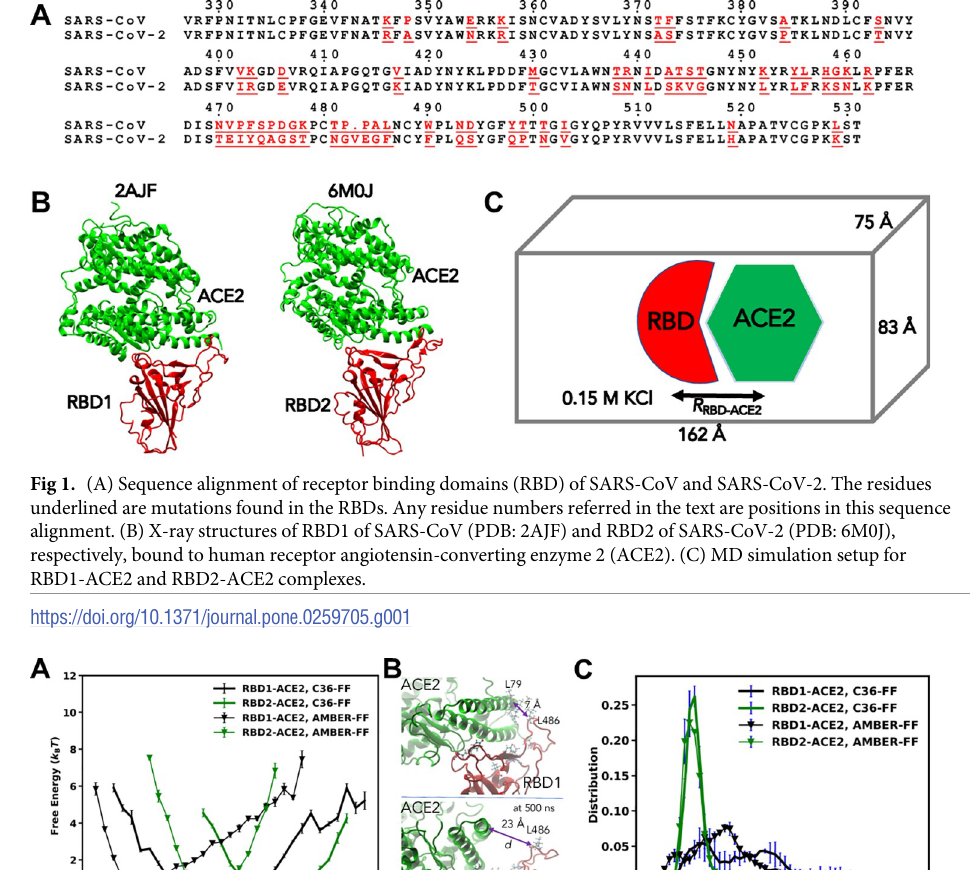
Figs 1, 3, and 4 are incorrect; the publisher apologizes for the errors. The authors have pro- vided corrected versions here.